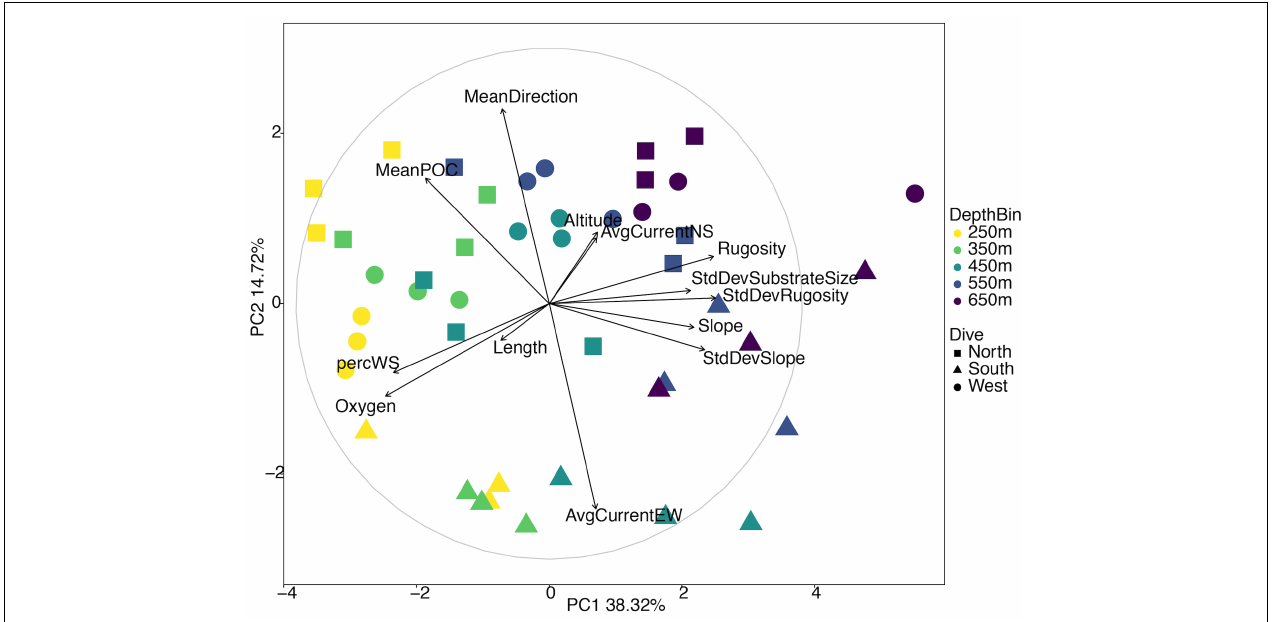
FIGURE 6 | Principal components analysis diagram of environmental variables for three slopes of Mokumanamana. Each point represents a single 1 km transect coded by depth and side.